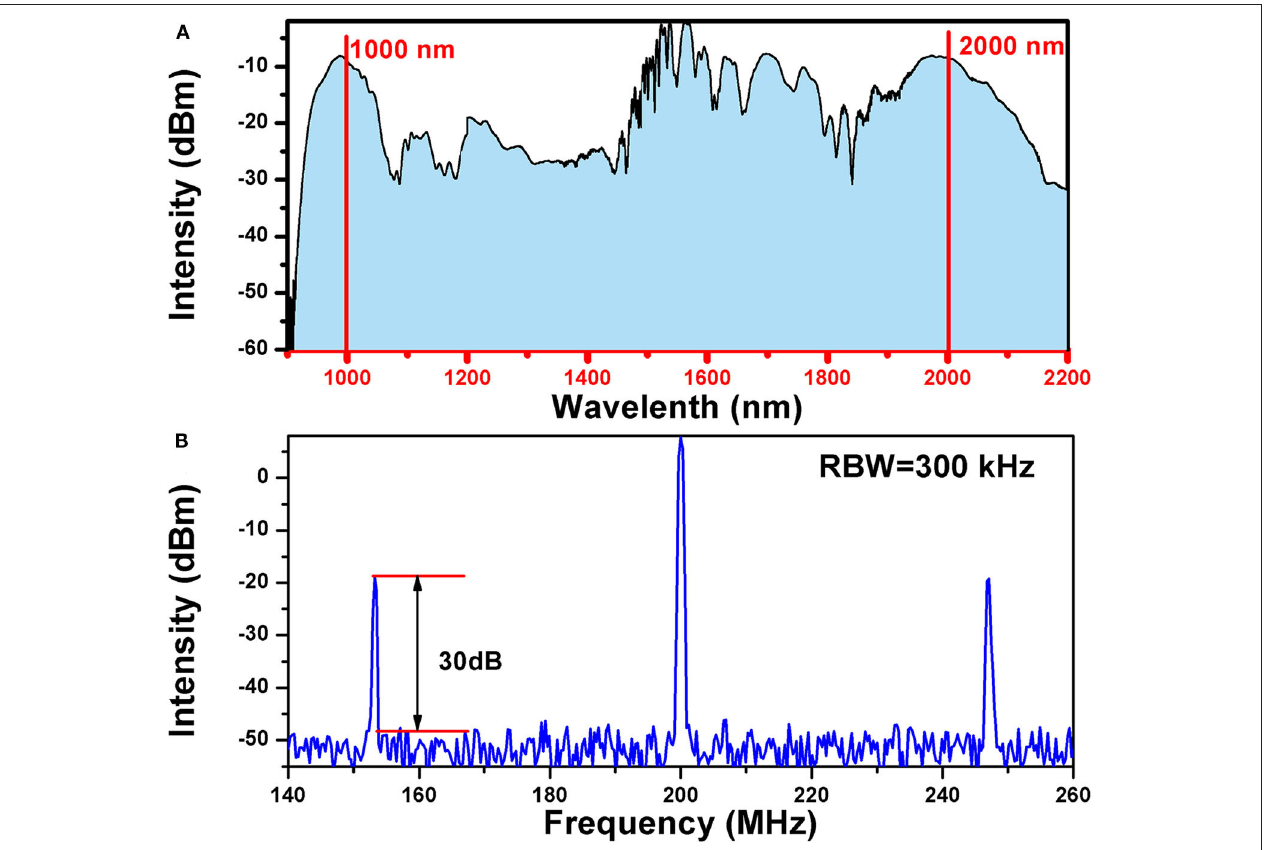
FIGURE 2 | (A) Octave-spanning super-continuum spectrum after the HNLF. (B) f ceo heterodyne signal at a 300kHz resolution bandwidth